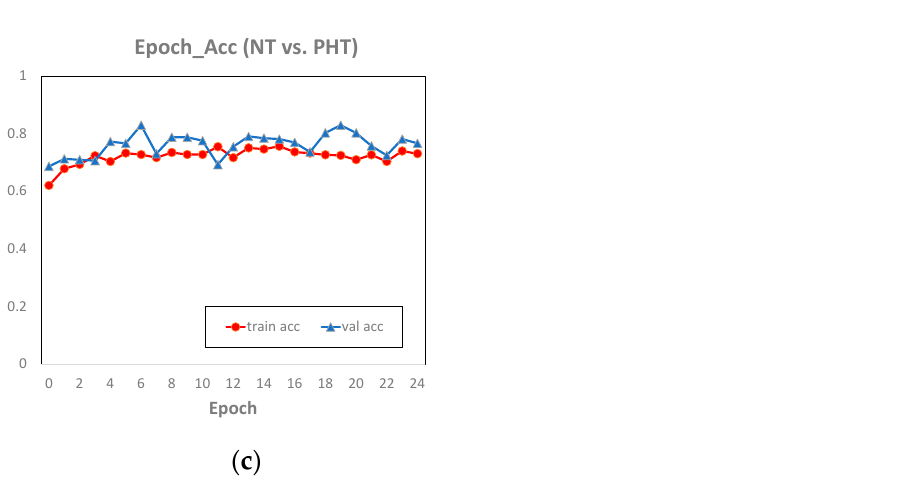
Figure 7. The diagram of epoch and accuracy (referred to as acc in the figure) of the NT vs. HT (a), NT+PHT vs. HT (b) and NT vs. PHT (c) in AlexNet.